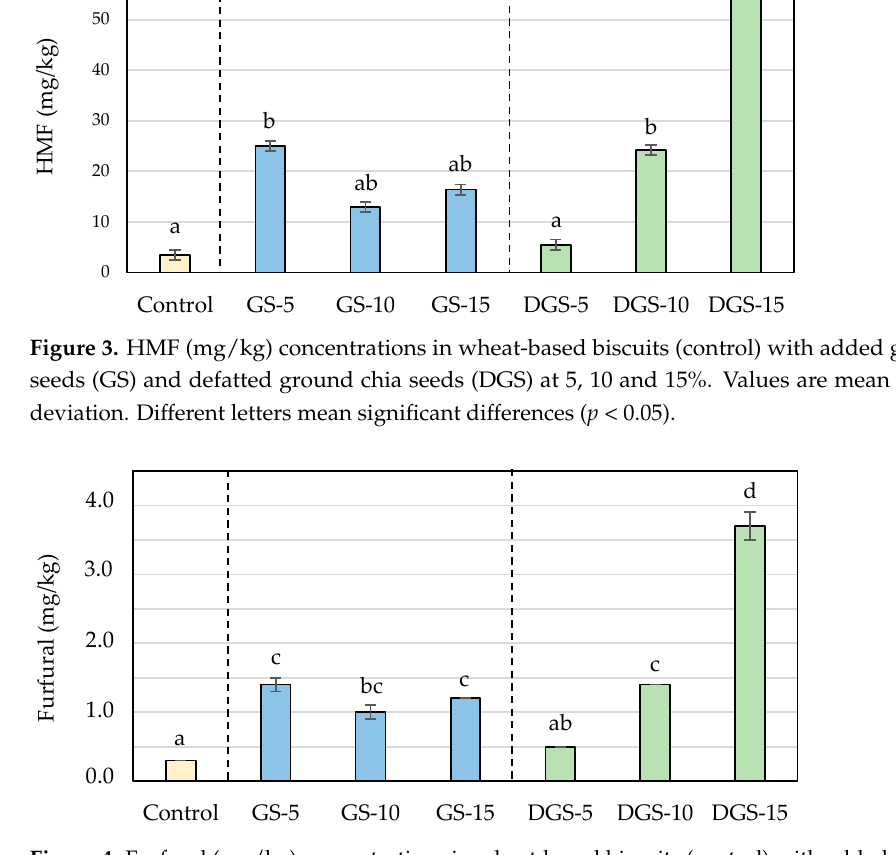
Figure 4. Furfural (mg/kg) concentrations in wheat-based biscuits (control) with added ground chia seeds (GS) and defatted ground chia seeds (DGS) at 5, 10 and 15%. Values are mean ± standard deviation. Different letters mean significant differences ( p < 0.05).